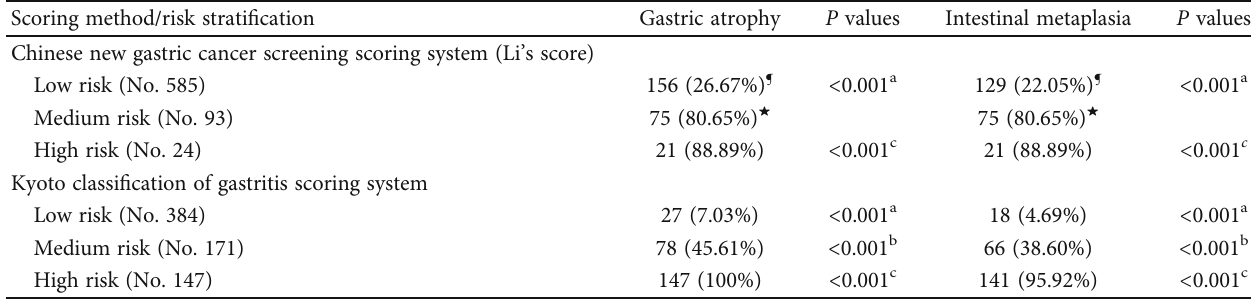
Table 4: Comparison of gastric atrophy and intestinal metaplasia results between the two scoring methods. Scoring method/risk strati fi